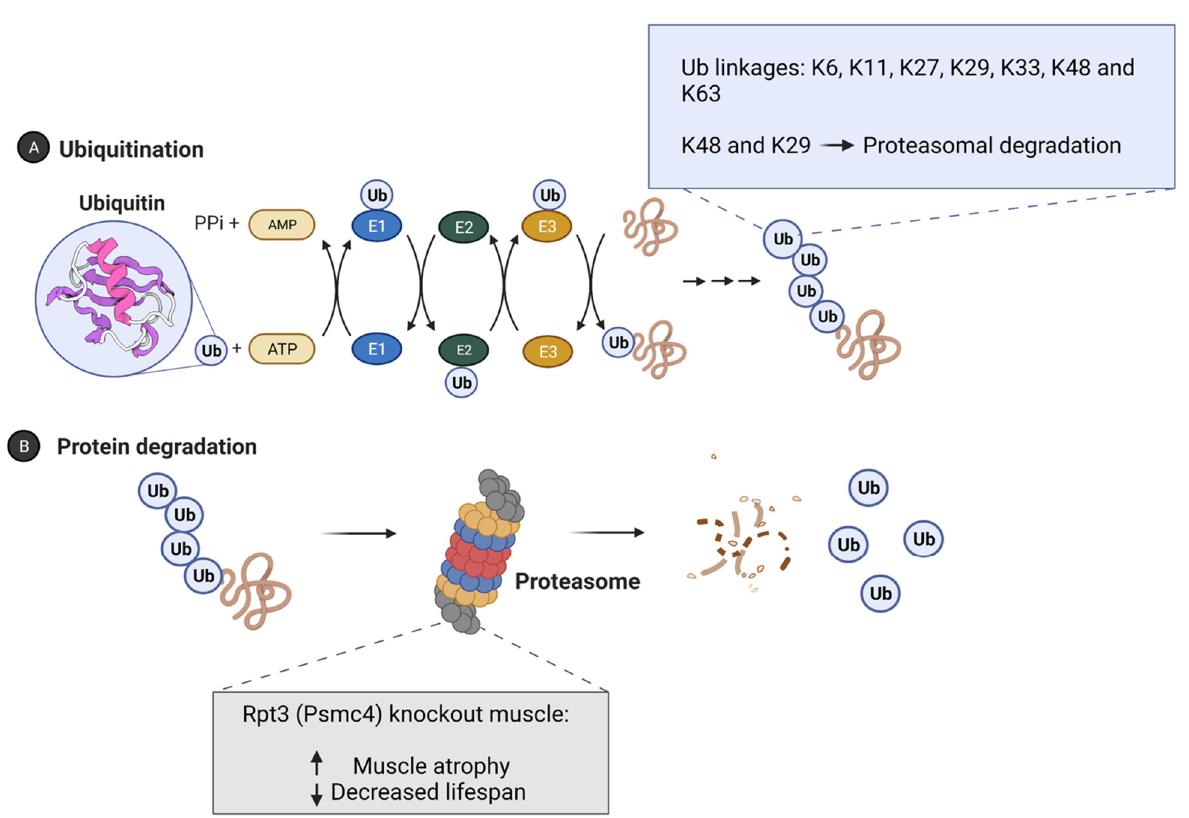
Figure 2. Overview of the ubiquitin–proteasome system (UPS) and the process of ubiquitination and protein degradation. The UPS contributes to the proteostasis network by utilizing ubiquitination, a process that involves covalently linking a small protein called ubiquitin to substrate proteins via a series of reactions involving ubiquitin–activating enzymes (E1), ubiquitin–conjugating enzymes (E2), and ubiquitin–protein ligases (E3; ~600 in the human genome ( A ) Ubiquitin, a 76-amino acid protein, is most commonly attached through the formation of an isopeptide bond with a lysine residue on the target protein. A substrate can be monoubiquitinated, multi-ubiquitinated, or polyubiquitinated. The non-proteolytic or proteolytic fate of a substrate protein is determined by the number and/or linkage of ubiquitin chains added. Ubiquitin contains seven lysines (K6, K11, K27, K29, K33, K48, and K63), and it has been suggested that proteins modified with K48 or K29 polyubiquitin-linked chains are targeted to the 26S proteasome for degradation while K63 chains can lead to alterations in signaling and endocytosis ( B ) Rpt3 is an essential subunit of the 26S proteasome core ( B ) and is required for the degradation of substrates selected to the proteasome. In Rpt3 knockout muscles, a significant loss of muscle mass and fiber size, dysregulation of the UPS system and a shortened lifespan has been observed. Created with Biorender.com (accessed on 22 June